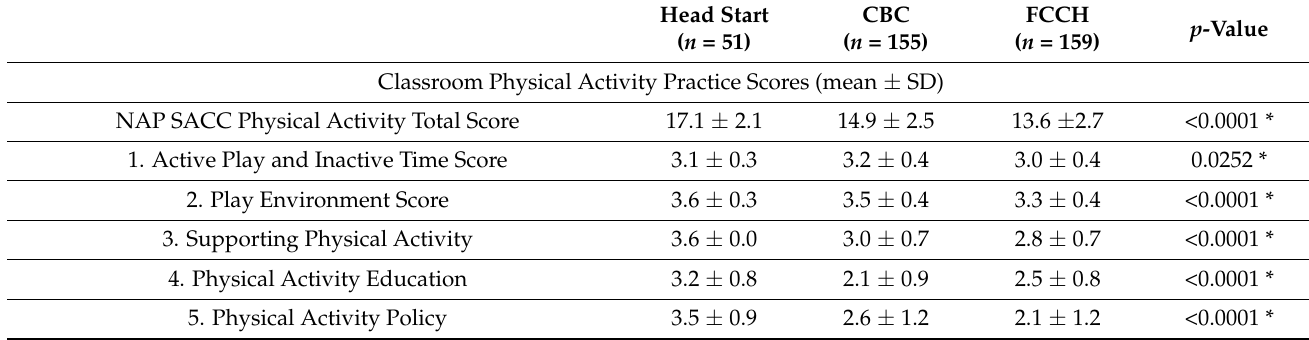
Table 2. Classroom physical activity practice scores and barriers among Oklahoma ECE programs participating in the Communities and Classroom Health Survey in 2019/2020, by childcare